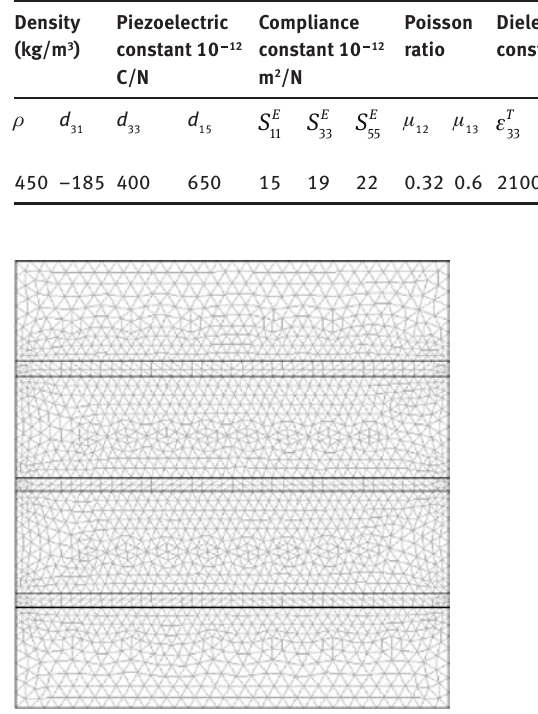
Figure 3: Finite model of OPCM longitude actuator